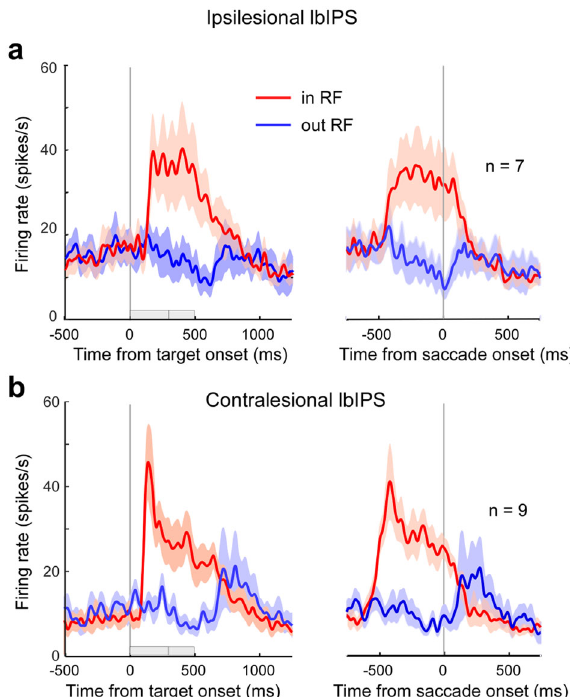
Fig. 5 Responses of lbIPS neurons during the overlap saccade task. Population activity of neurons in the ipsilesional ( a ) and contralesional ( b ) lbIPS during the overlap visually guided saccade task. The left and right panels are aligned to target onset and saccade onset (vertical gray line), respectively. The red traces indicate the mean fi ring rate when the target was presented in the RF. Blue traces indicate the mean fi ring rate when the target was presented outside the RF. Shaded areas indicate SEM. Gray bars on the horizontal axis of the left panels indicate the overlap periods of the FP and target (varying between 300 and 500